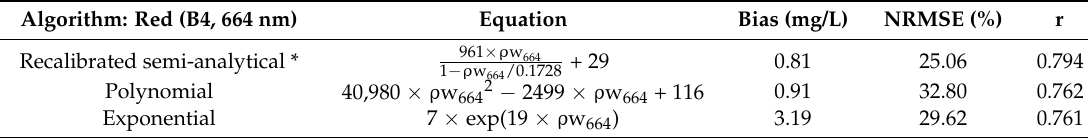
Table 2. Algorithms tested for Total Suspended Solids (TSS) estimation in the Guadalquivir estuary based on the water reflectance ( ρ w) of the red band (B4, 664 nm). The Pearson correlation coefficient (r, p < 0.001), bias (mg/L), and Normalized Relative Root Mean Square Error (NRMSE, %) are indicated with the final equation for each one. The * corresponds to the Nechad et al. (2009) model [29]. Algorithm: Red (B4, 664 nm)